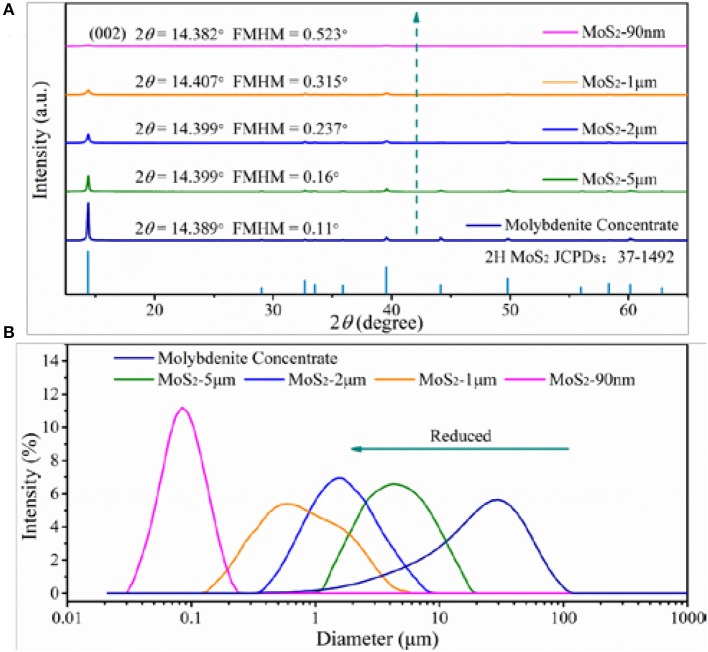
(A) XRD spectra of molybdenite concentrate and MoS2 samples. (B) Particle size analysis of molybdenite concentrate and MoS2 samples.